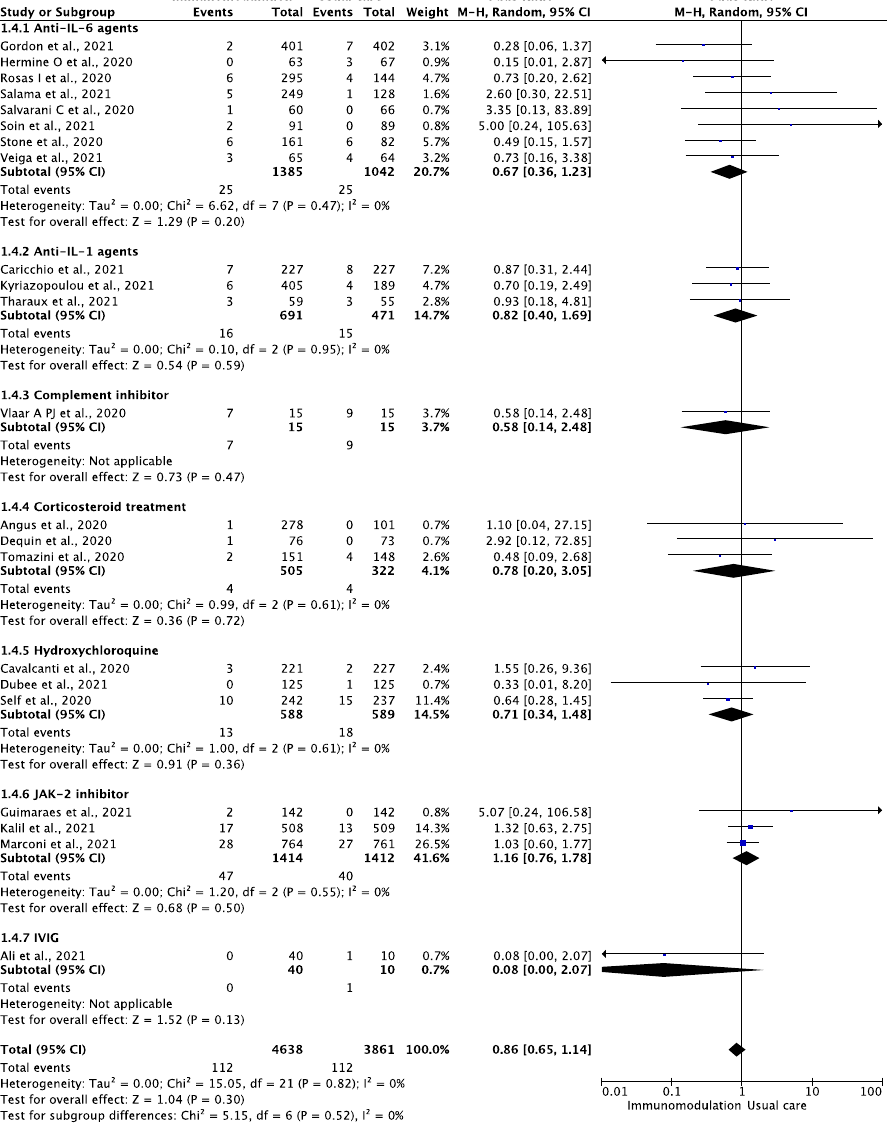
Figure 4. Odds ratio (OR) and 95% confidence intervals for the occurrence of any thromboembolic event among the hospitalized COVID-19 patients prescribed immunomodulatory agents as an add-on to SOC vs. SOC only. Boxes represent the OR and lines represent the 95% CIs for individual studies. The diamonds and their width represent the pooled ORs and the 95% CIs, respectively. CI, confidence interval for the Mantel–Hansen estimator, I 2 : heterogeneity.